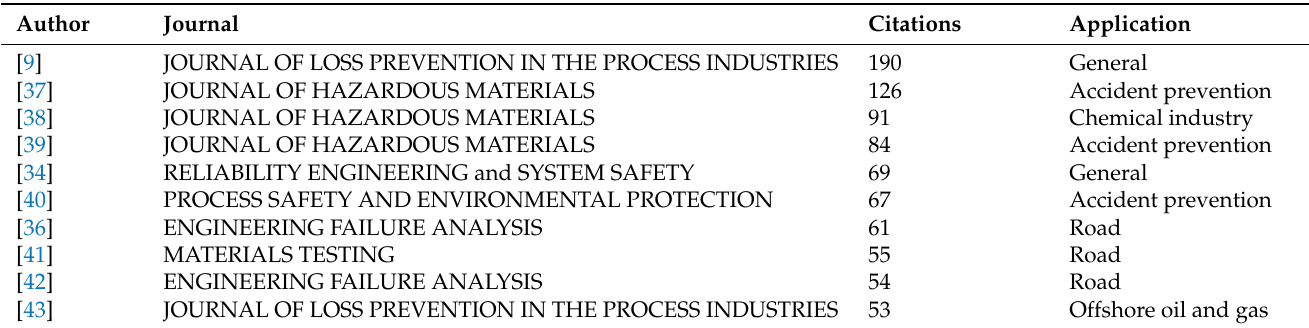
Table 2. Top 10 papers by number of global citations.